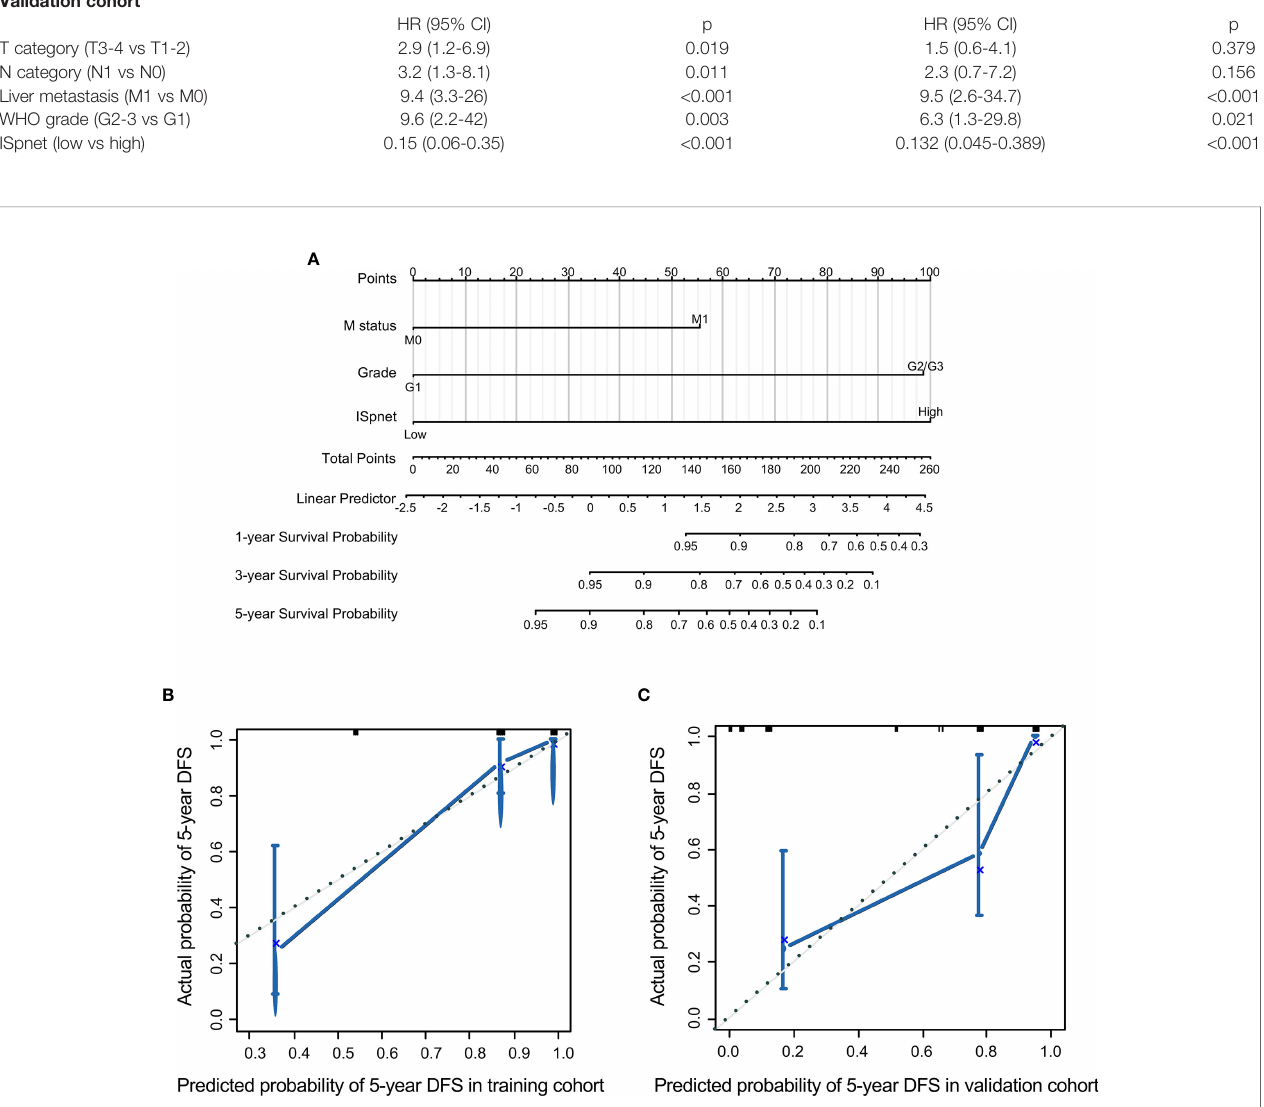
FIGURE 4 | Nomogram for predicting the RFS of Pan-NET patients. (A) Nomogram scoring system based on the independent predictors from the multivariable Cox regression analysis to predict the risk of RFS in Pan-NETs. (B, C) Calibration plots of the nomogram to predict RFS at 5 years in the training cohort and the validation cohort, indicating good agreement between the prediction and the